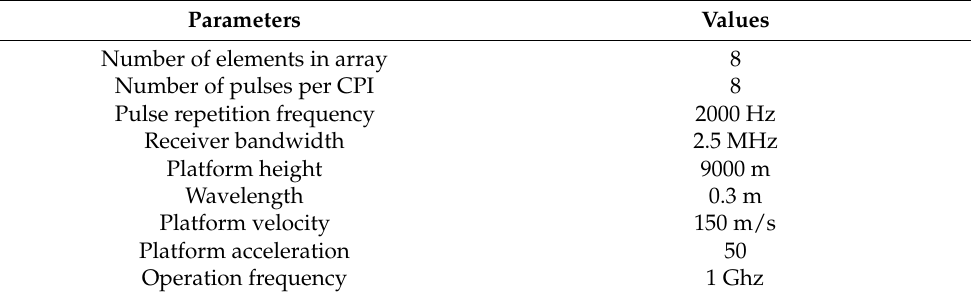
Table 2. Simulation parameters of the radar